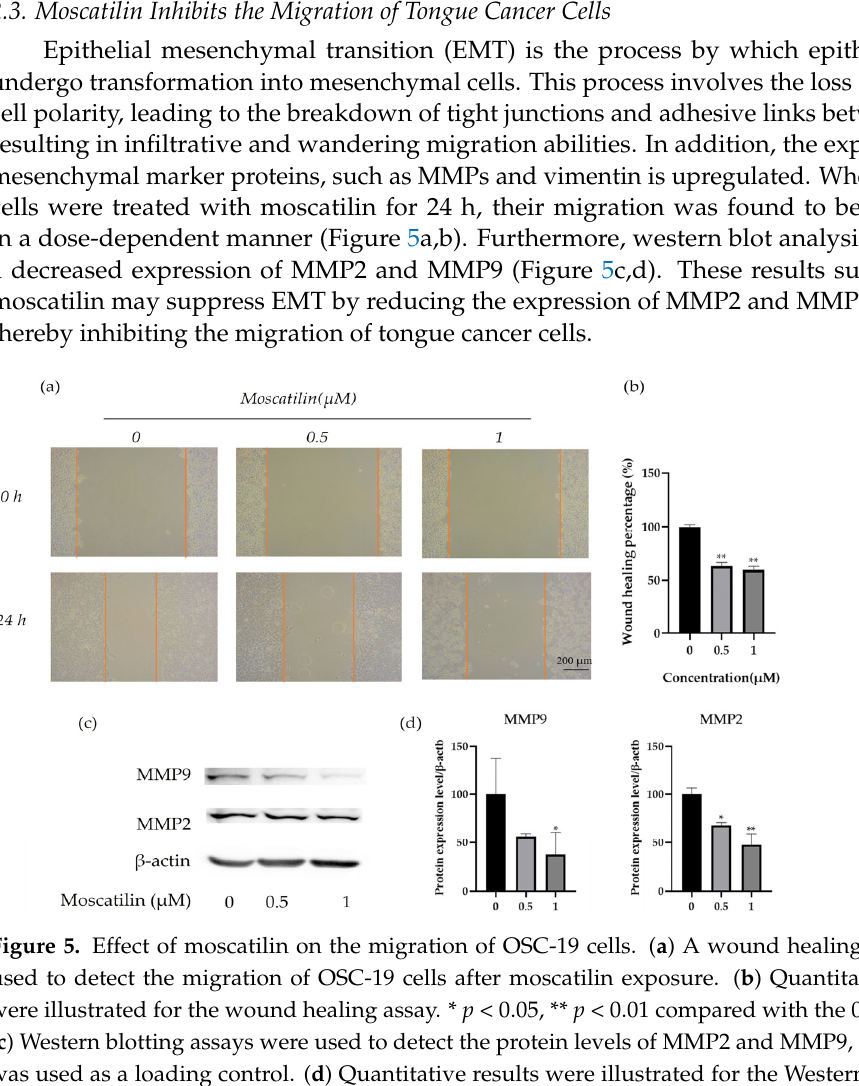
Figure 4. Cytotoxicity of moscatilin on OSC-19 cells. MTT assay was used to detect cell viability in OSC-19 cells after compound 3 – 6 exposure. n = 5, ** p < 0.01, compared with the 0 µM group.